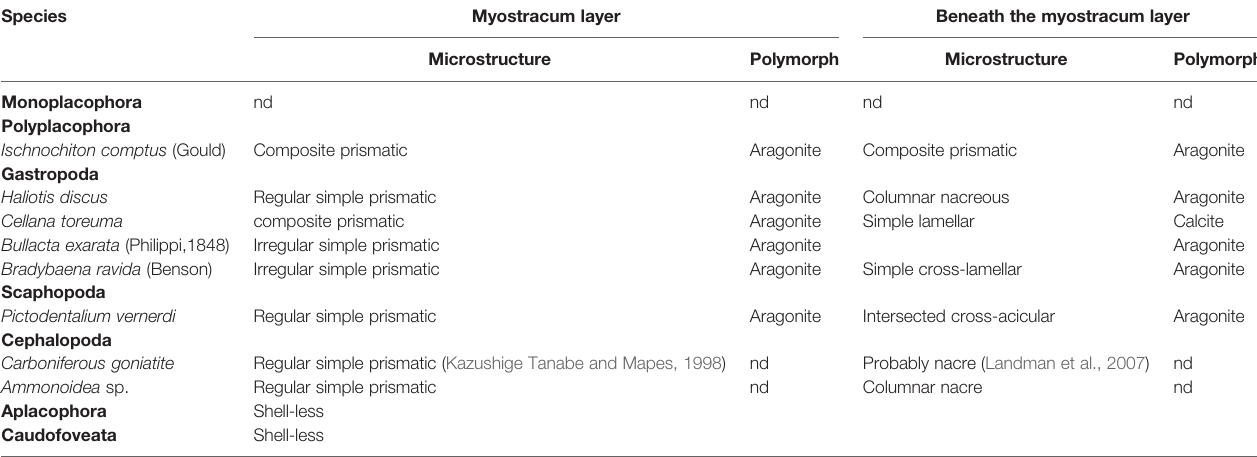
TABLE 2 | Summary of the microstructure and texture of tested shell layers in the species